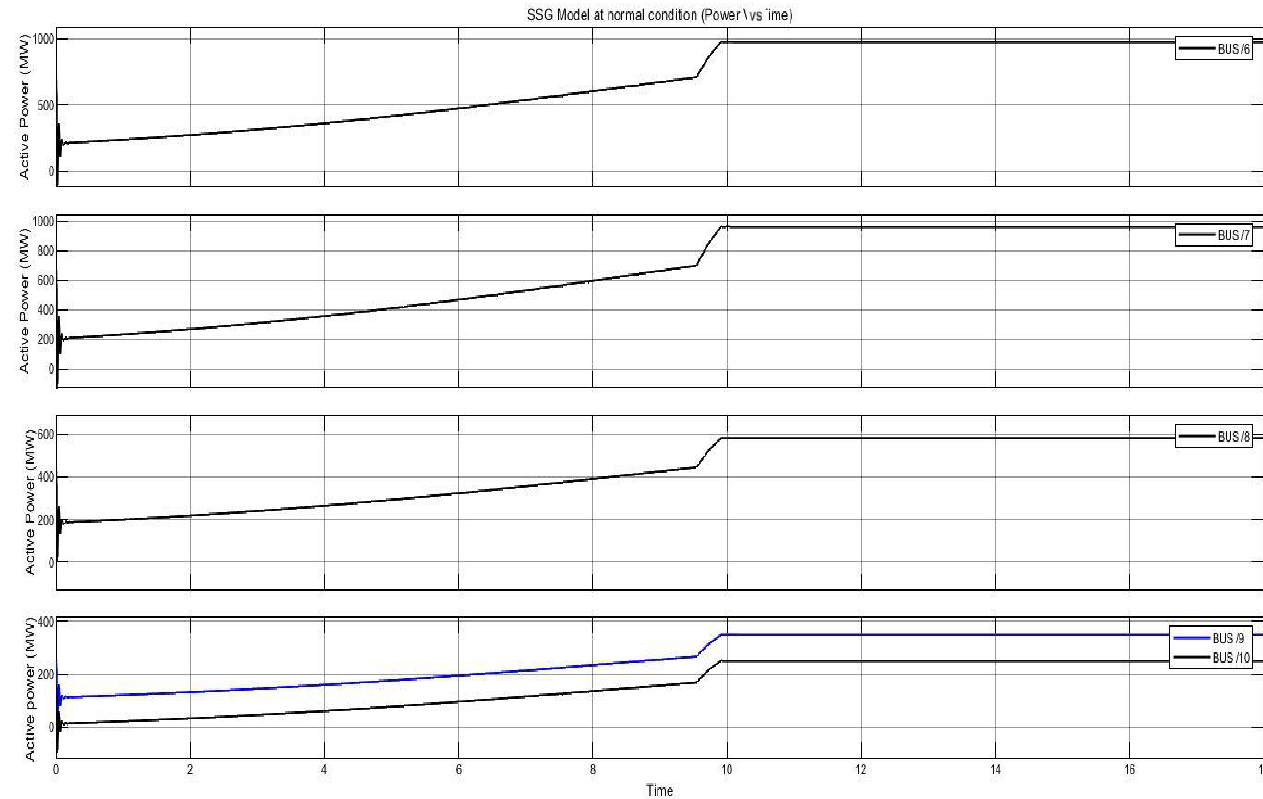
Figure 17. System in normal state, and no fault is introduced (Bus 6 to Bus 10).